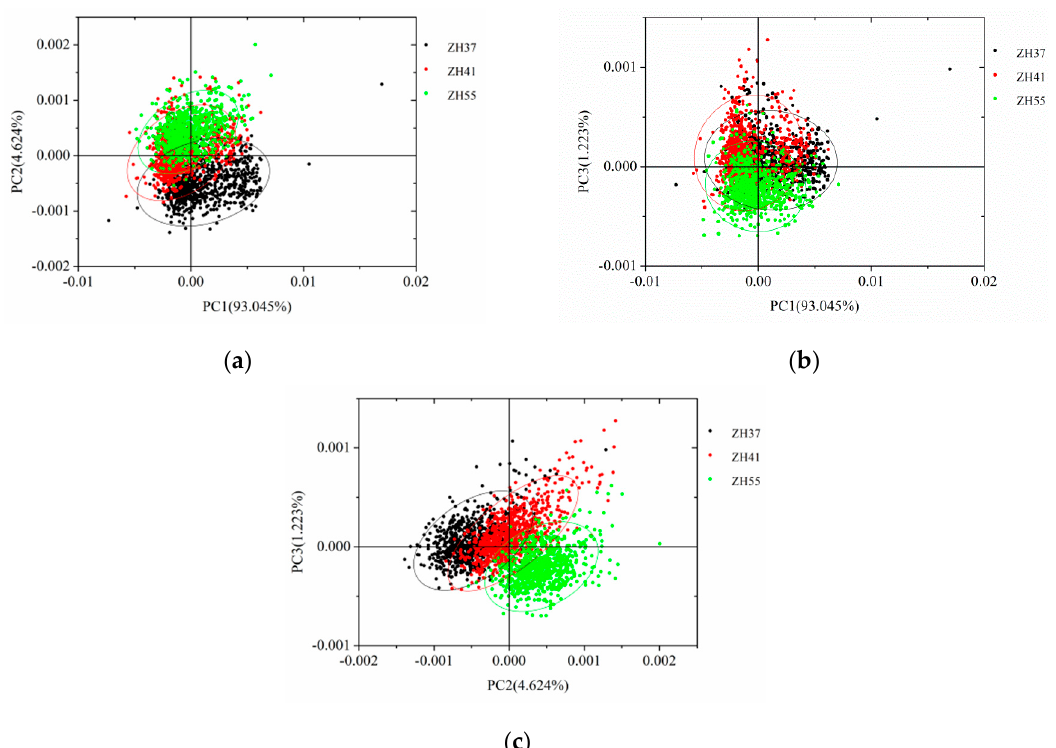
Figure 5. Scores scatter plot of soybeans ( a ) PC1 vs. PC2; ( b ) PC1 vs. PC3; ( c ) PC2 vs. PC3. PC: principal components.